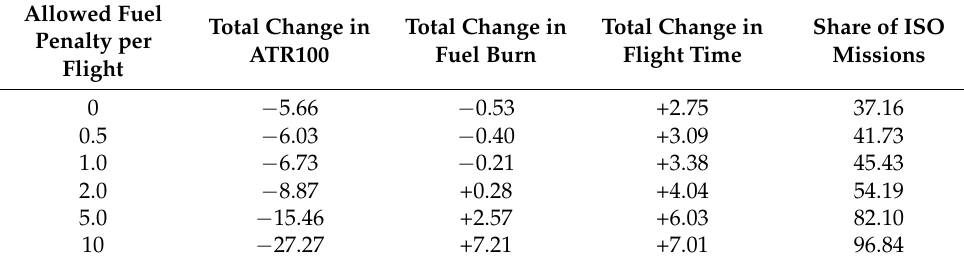
Table 2. Climate impact mitigation when limiting additional fuel burn per flight (all numbers in % compared to the reference